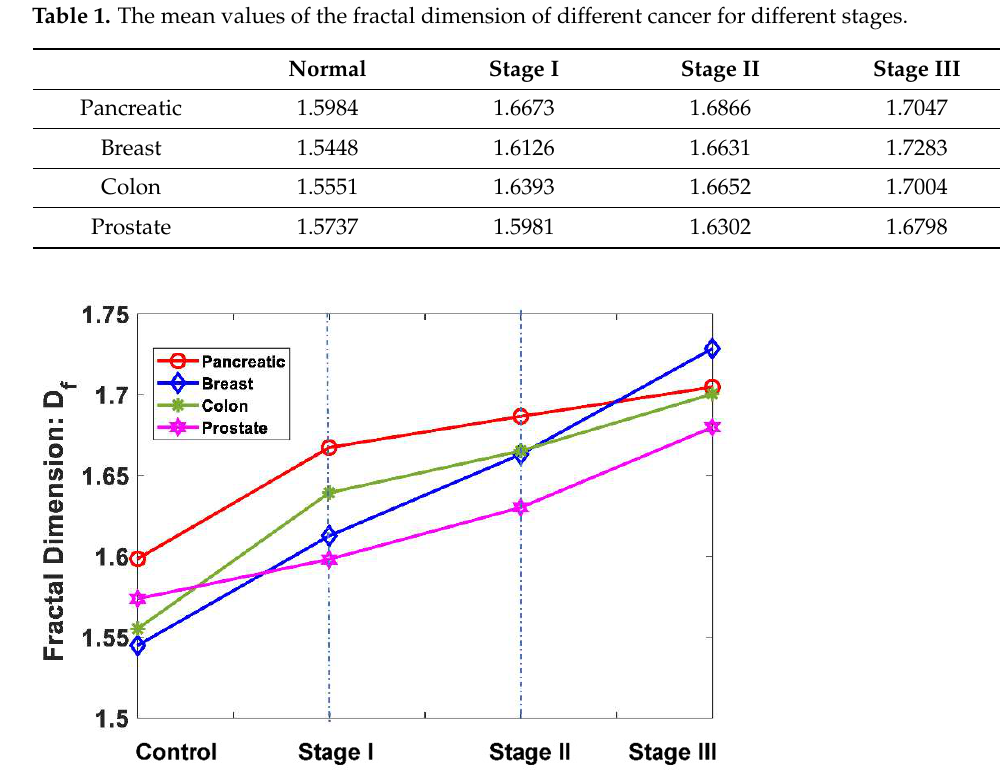
Figure 6. The plot of the systematic increases in the fractal dimension with the progress of the cancer stages. The x-axis steps are false steps that are measured by an equal distance unit of 1 for increasing stages, for better presentation. It can be seen that the fractal dimension on average increases with the stage; however, they take slightly different paths. Note: only mean values are shown, standard errors are the same as shown in bar graph